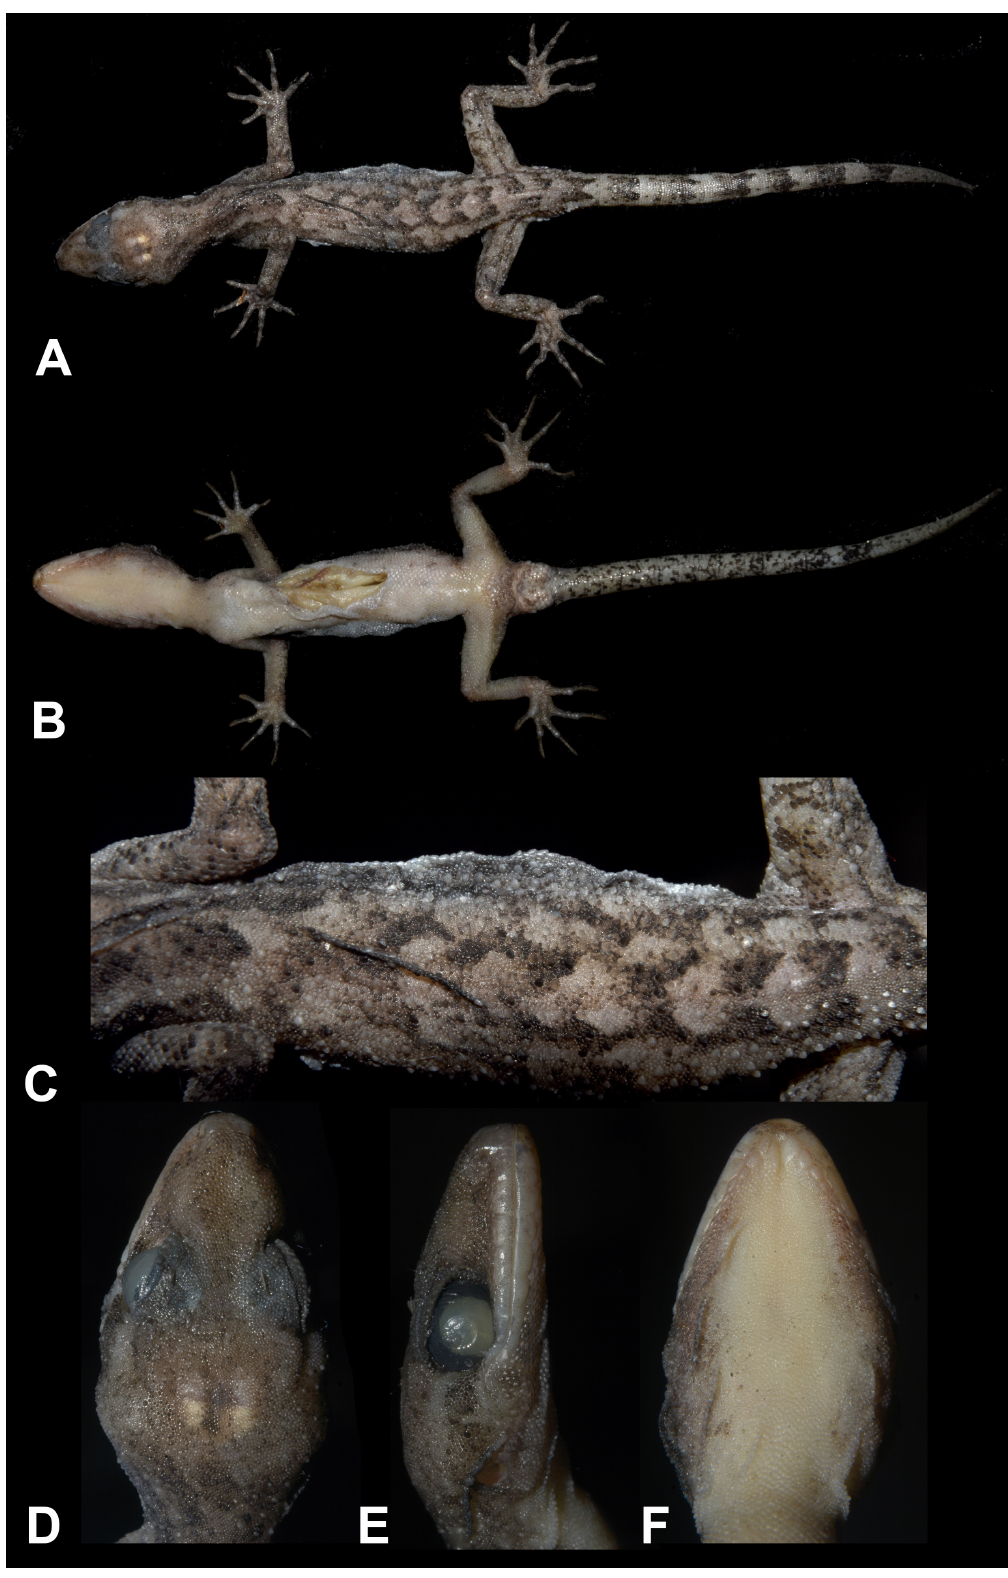
Fig. 8. Cyrtodactylus siahaensis sp. nov., holotype (MZMU2445). A . Dorsal view. B . Ventral view. C . Details of dorsal pholidosis. D . Dorsal view of head. E . Lateral view of head. F . Ventral view of